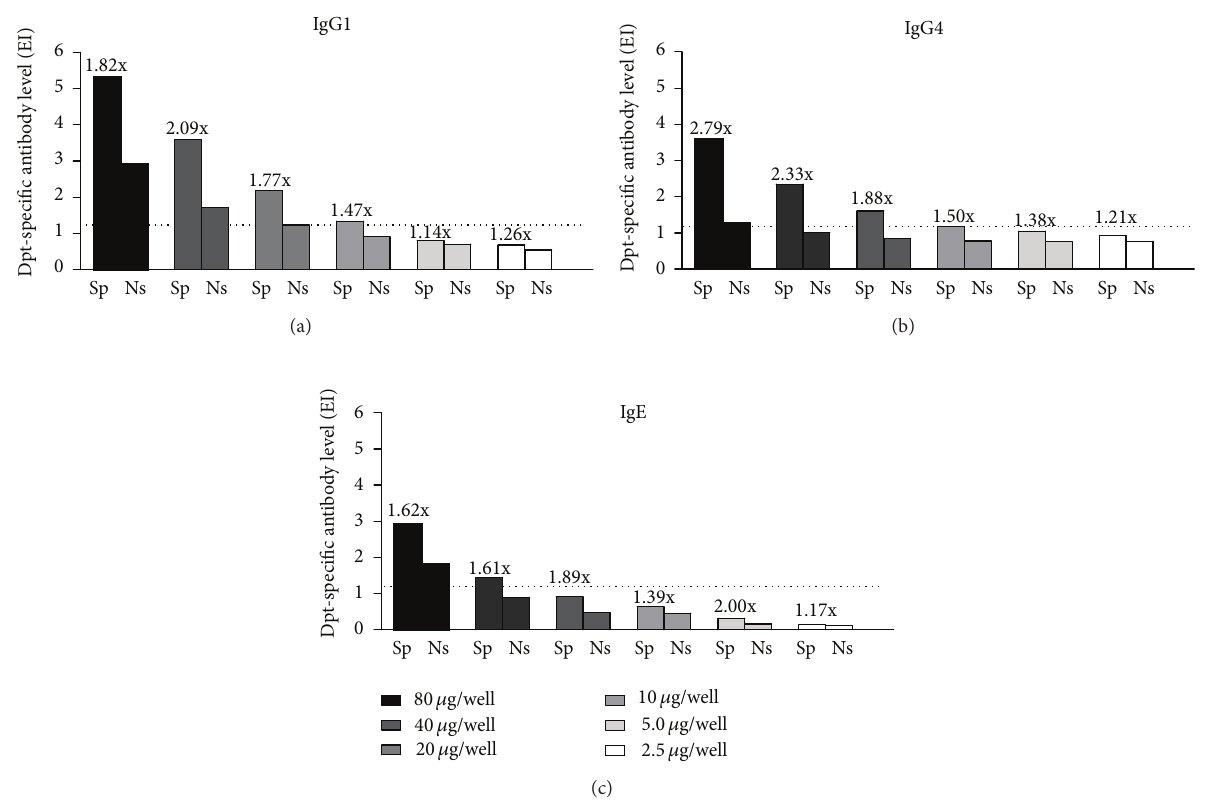
Figure 4: Levels of IgG1 (a), IgG4 (b), and IgE (c) antibodies to Dermatophagoides pteronyssinus (Dpt) allergen extract in the specific (Sp) and nonspecific (Ns) purified IgG fractions obtained from atopic and nonatopic patients, respectively, determined by ELISA. Purified IgG fractions were titrated at two-fold dilutions from 80 to 2.5 𝜇 g/well, and data are expressed in ELISA index (EI). The dashed lines indicate the cutoff of the reaction (EI > 1.2 ). The values indicating the Sp/Ns ratio for each antibody class and analyzed concentration are also indicated.